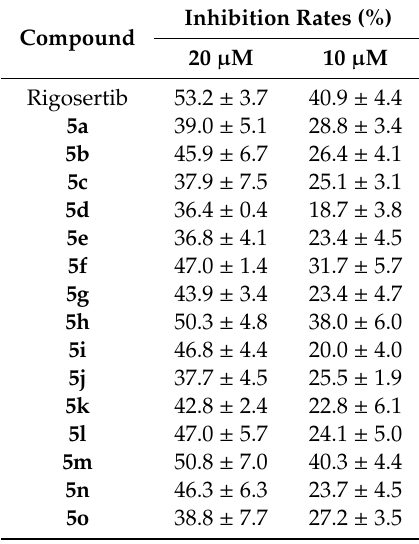
Table 2. Cytotoxicity of compounds 5a - 5o against five cancer cell lines.